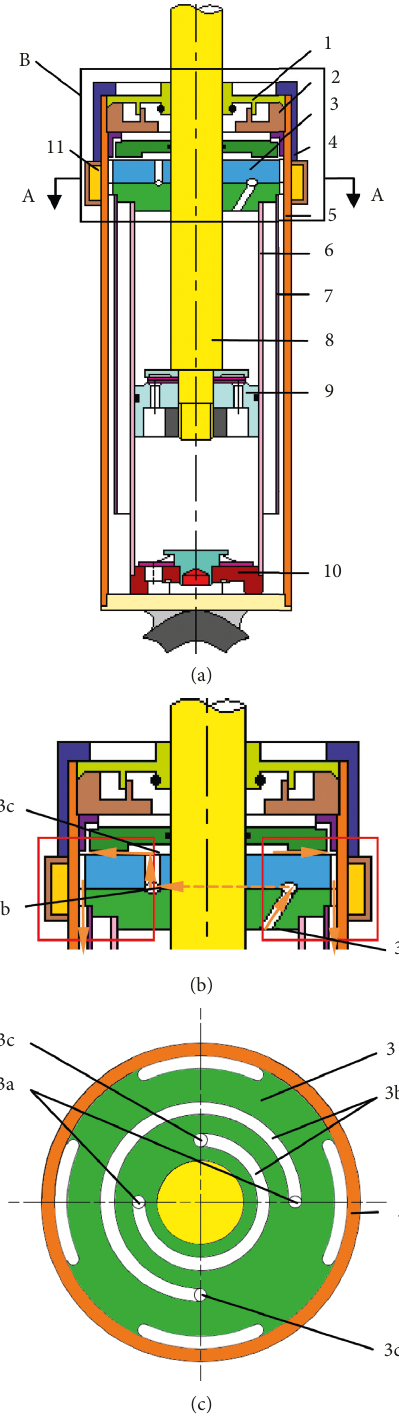
Figure 15: (a) Schematic view of MR damper with spiral valve. (b) Schematic view of the region enclosed by square in (a). (c) Cross-sectioned bottom view of the rod guide. 1, seal; 2, seal seat; 3, guide assembly; 3a, inlet; 3b, spiralling passages; 3c, outlet; 4, end plate; 5, outer tube; 6, inner tube; 7, dome; 8, piston rod; 9, piston; 10, foot valve; 11, coil